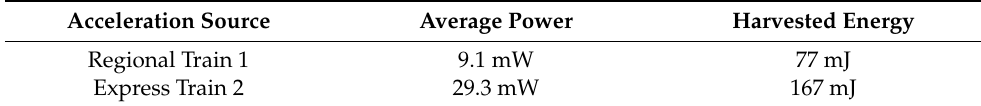
Table 2. Harvested power and energy with optimal load resistance.